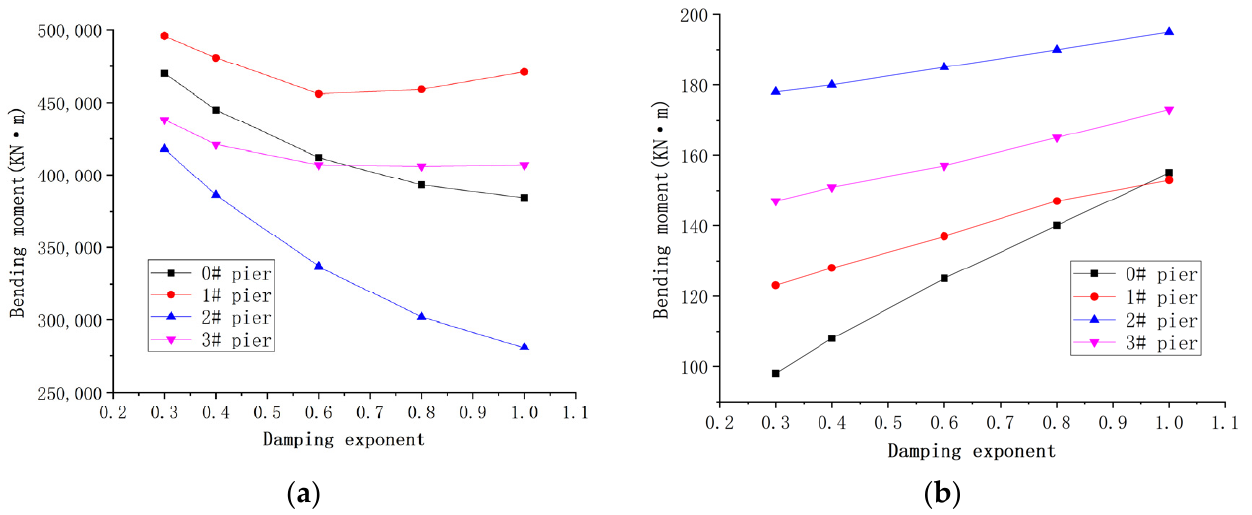
Figure 13. Seismic response of the longitudinal bridge direction (damping exponent α ). ( a ) Bending moment at the bottom of pier. ( b ) Relative displacement between piers and beams. With the increase in the damping exponent, the bending moment at the bottom of the pier first decreases and then increases; however the bending moment of the pier bottom of the 2# pier decreases gradually; for the relative displacement between the piers and beams, with an increase in the damping exponent, the displacement response gradually